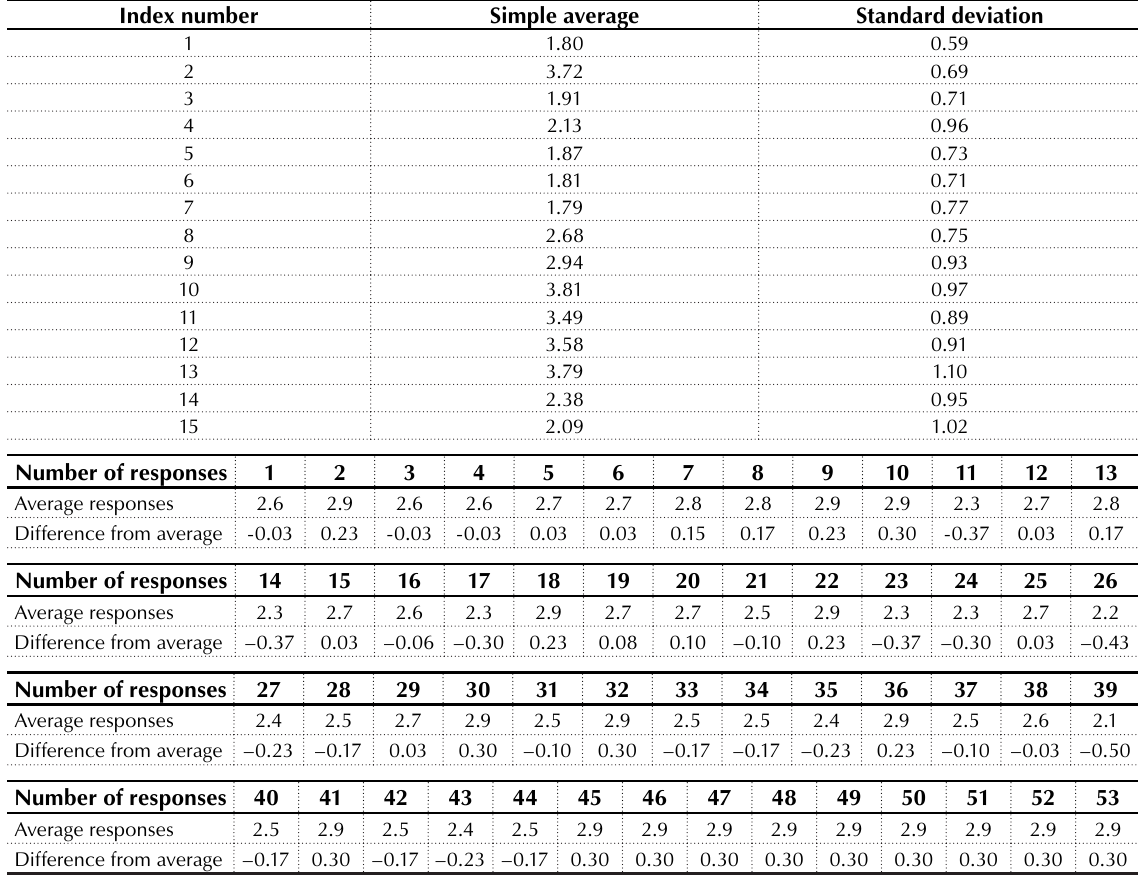
Table 6. The mean and standard deviation of the managerial positions questionnaire SRP1 before Delphi revision